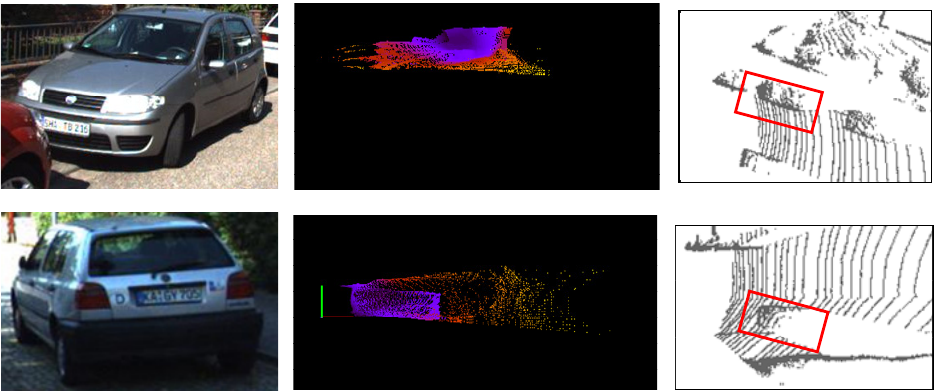
Figure 1. Architecture of our proposed method. Considering the lack of depth information of the monocular image, we fuse the pseudo point cloud information and image information to perform keypoint-based initial 3D object estimation. In order to make up for the information losing due to the convolution or pooling in the initial estimation stage, we refine the initial 3D box in the XZ plane using the bird’s-eye view generated from the pseudo-point cloud.